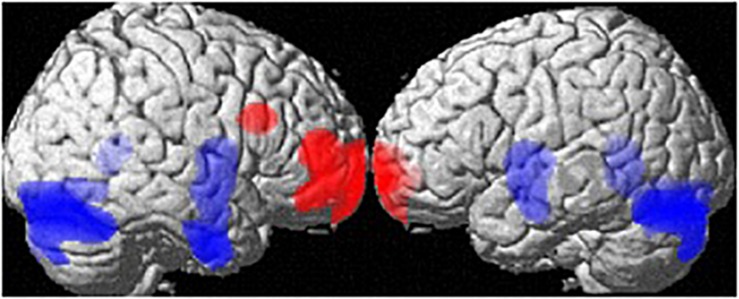
Sex differences in regional gray matter volumes. Areas with larger regional volumes in men are depicted in blue (Cerebellum, Hippocampus/Parahippocampus, Amygdala, Putamen). Areas with larger regional volumes in women are depicted in red (frontal pole, middle/inferior frontal gyrus).